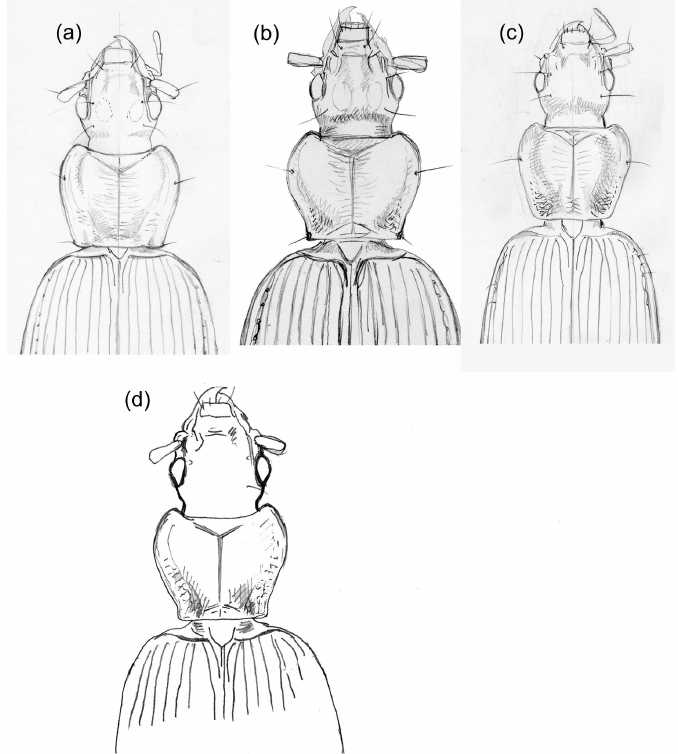
Figure 10. Historical materials of some Platynus species: ( a ) P. sexualis K. and J. Daniel 1898. Type ♂ ; ( b ) P. complanatus Dejean, 1828. Lectotypus ♀ (MNHN); ( c ) P. peirolerii Bassi, 1834 from de Breme ♀ Coll. (MRSN); ( d ) P. complanatus Dejean, 1828. Dejean Coll. (MNHN). Original drawings by A. Casale.